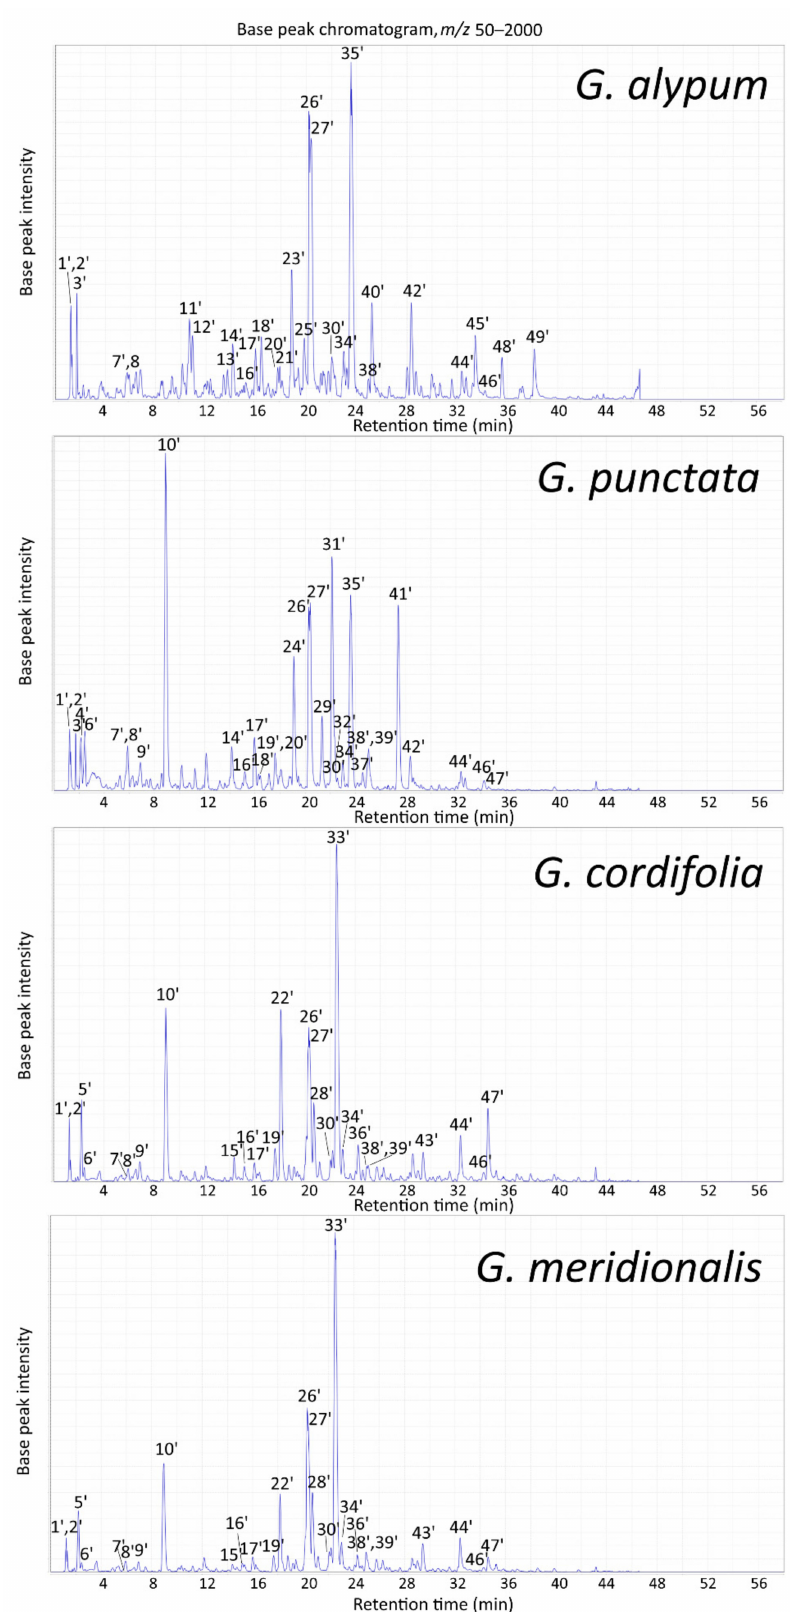
Figure 2. LC-MS base peak chromatograms of methanolic aerial parts extracts from G. alypum , G. punctata , G. cordifolia and G. meridionalis obtained by Soxhlet extraction. Numbers on chro- matograms refer to compounds listed in Table